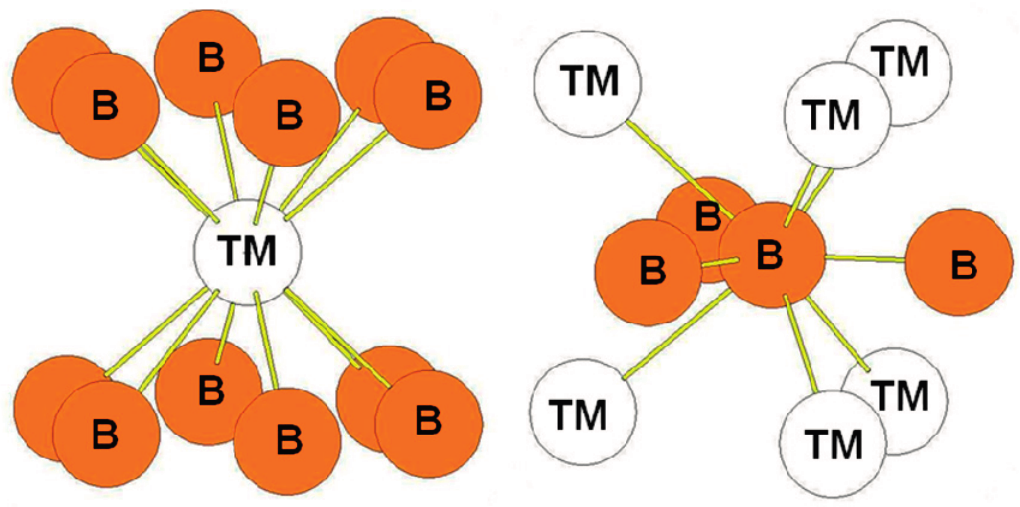
Figure 3. Environment of TM and B atoms in the hP3 (AlB 2 -type) structure.